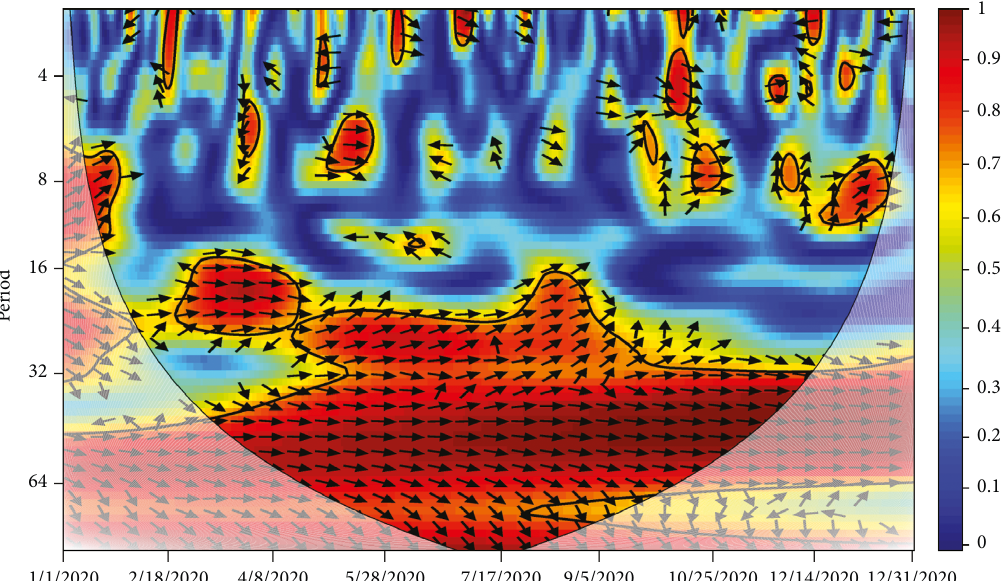
Figure 2: Illiquidity vs. VIX wavelet coherency (tranquil period). Note: this figure reports the wavelet coherency between illiquidity and VIX during tranquil period. The black contour represents the regions in which the spectrum is significant at the 5% level against red noise. The cone of influence denoted as COI is designated by the lighter shade which delineates the high power regions. Time and scale (days) are represented on the horizontal and vertical axes, respectively. Arrows pointed to the right (resp. left) signify that the variables are in phase (out of phase). If arrows move to the right and up (resp. down), the first variable is the driver (resp. follower). By contrast, if arrows move to the left and up (down), the second variable is leading (resp. lagging).